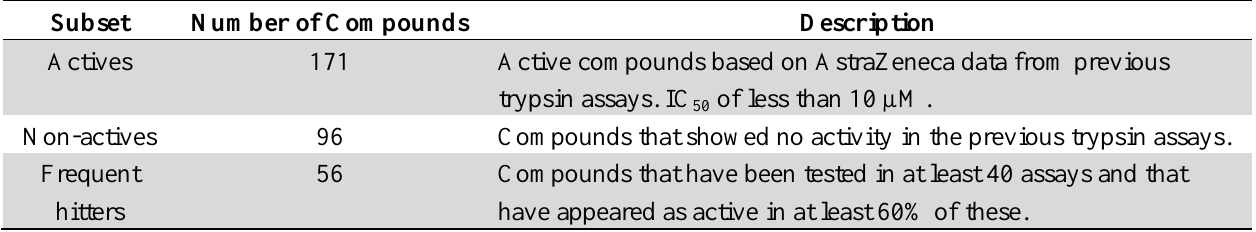
Table 2. Subsets of the test set. The selected compounds were divided into three different subsets depending on their previously found activity as outlined under